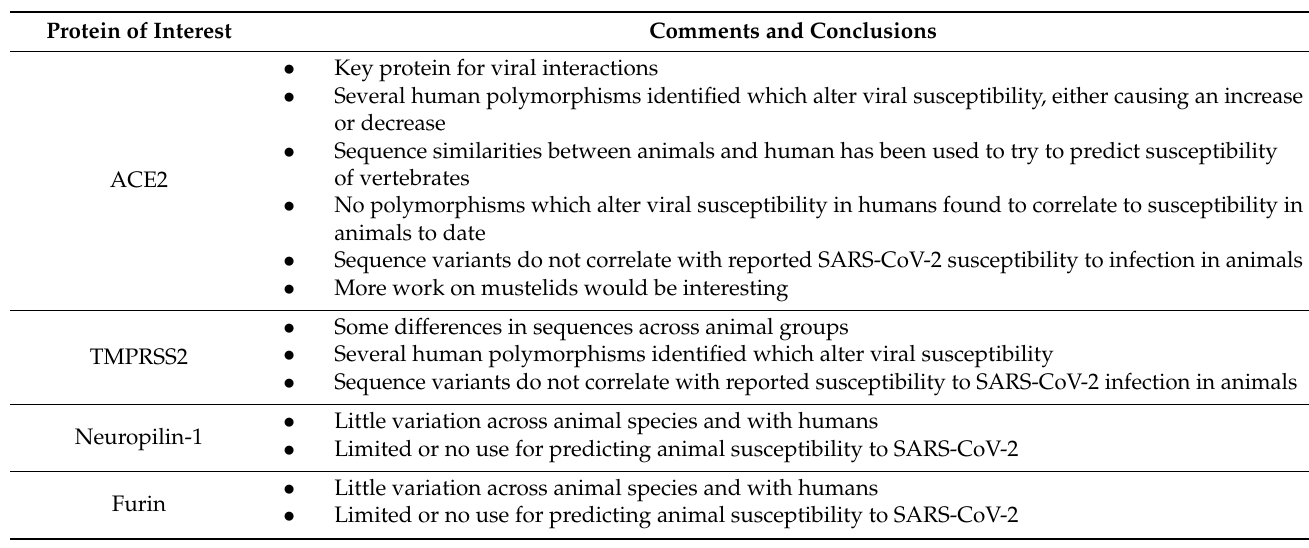
Table 3. A summary of pertinent points about the proteins analyzed.